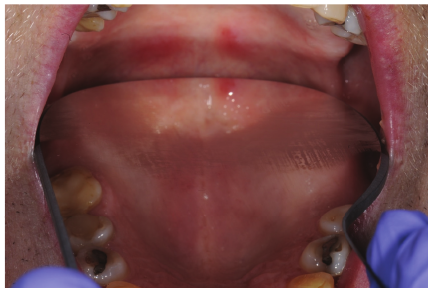
Figure 2: Clinical appearance of erythematous lesions in the soft